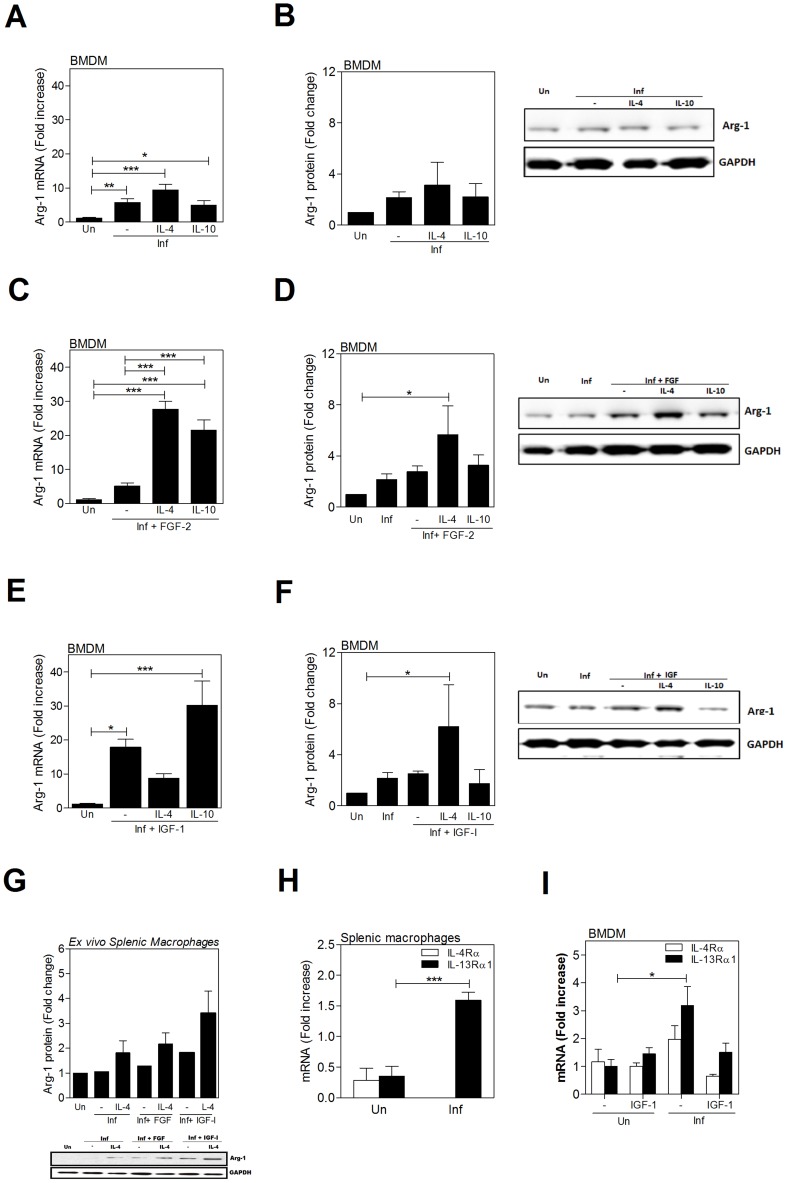
IL-4 enhances growth factor-induced arg1 in L. donovani infected macrophages.Infected hamster BMDM were exposed or not to hamster IL-4 (25 IU/mL), recombinant human IL-10 (100 ng/mL), recombinant human FGF-2 (20 ng/mL) and/or recombinant human IGF-1 (100 ng/mL) for 24 or 48 hrs. A, C, E) Arg1 mRNA expression determined by qRT-PCR at 24 hrs post-treatment. Shown is the mean and SEM of 6 replicates from a single experiment that was representative of 2 independent experiments. B, D, F) Arg1 protein expression determined in L. donovani infected BMDM exposed to IL-4, IL-10, and growth factors, alone or in combination, for 48 hrs. The membranes were stripped and stained with antibody against GAPDH to confirm equivalent protein loading. Bars represent the fold change with reference to control cells of uninfected hamsters calculated by densitometry analysis of immunoblot bands from 3 independent experiments. Also shown is a representative individual immunoblot. G) Arg1 protein expression determined in splenic macrophages from uninfected and L. donovani infected hamsters exposed ex vivo to IL-4 and growth factors, alone or in combination, for 48 hrs. The membranes were stripped and stained with antibody against GAPDH to confirm equivalent protein loading. Bars represent the fold change with reference to control cells of uninfected hamsters calculated by densitometry analysis of immunoblot bands from 3 independent experiments. Also shown is a representative individual immunoblot. H) Expression of IL-13Rα1 and IL-4Rα mRNA in splenic macrophages from uninfected (0) or 18-day infected hamsters determined by qRT-PCR. I) Expression of IL-13Rα1 and IL-4Rα mRNA in BMDM from uninfected (Un) and L. donovani infected (Inf) BMDMs (24 hrs p.i.) stimulated or not with IGF-1 or FGF-2. Shown is mean and SEM of the fold increase of receptor expression over uninfected, unstimulated controls from a single experiment representative of 2 independent experiments. *p<0.05; **p<0.01; ***p<0.001.